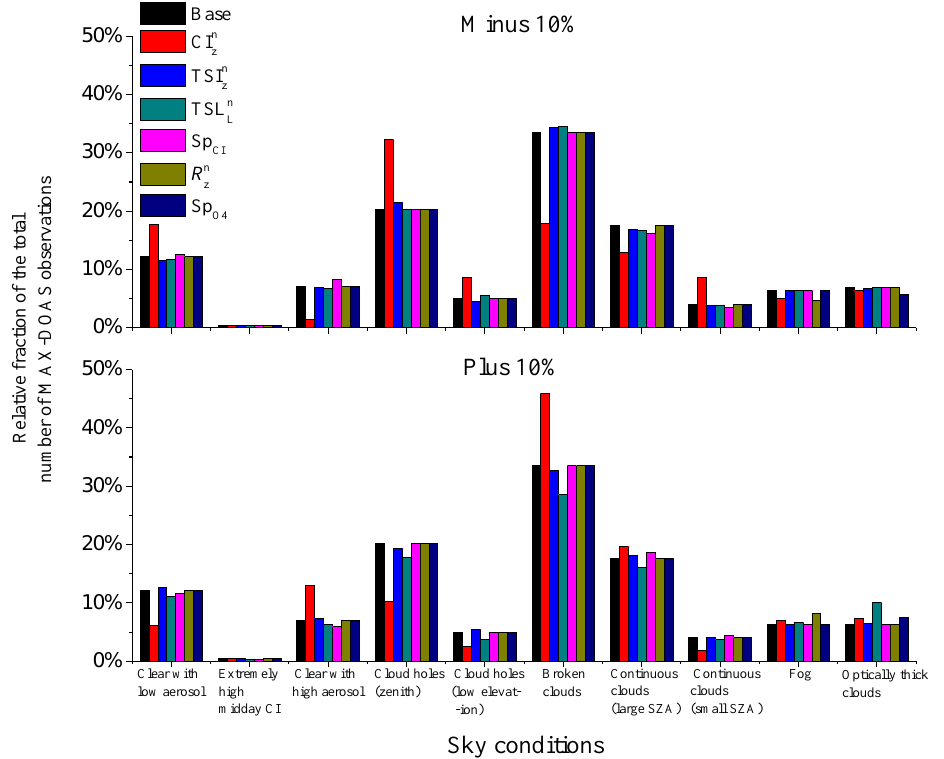
Figure 12. Results of the cloud classification scheme for slightly changed threshold values (top: + 10%, bottom: − 10%) for the individual measured quantities. The black columns show the results using the unchanged thresholds. The colored columns show the classification results if only one threshold value was changed (see